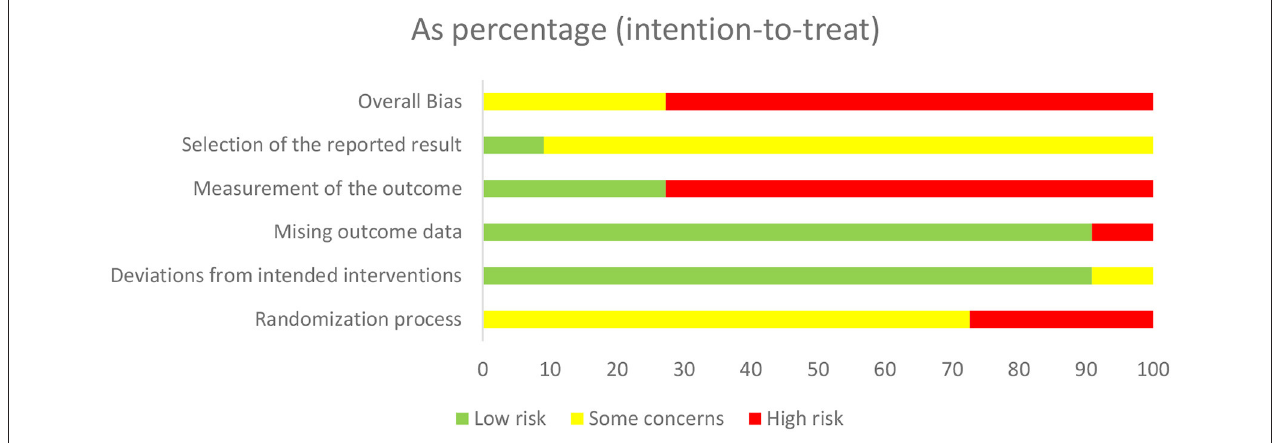
FIGURE 2 | Percentage distribution of risk of bias in individual studies (RoB